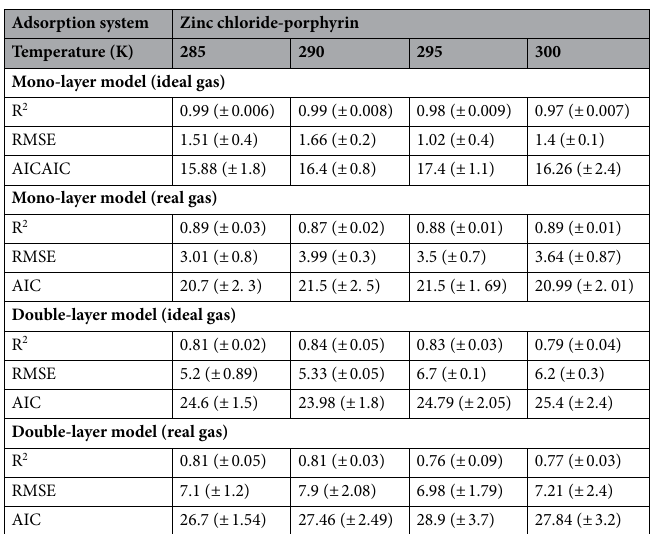
Table 2. Values of the correlation coefficient R 2 , the residual root mean square coefficient RMSE and the Akaike information criterion AIC deduced from fitting the experimental adsorption isotherms of ZnCl 2 on 5,10,15,20-tetrakis(4-methylphenyl) porphyrin with the four advanced models.